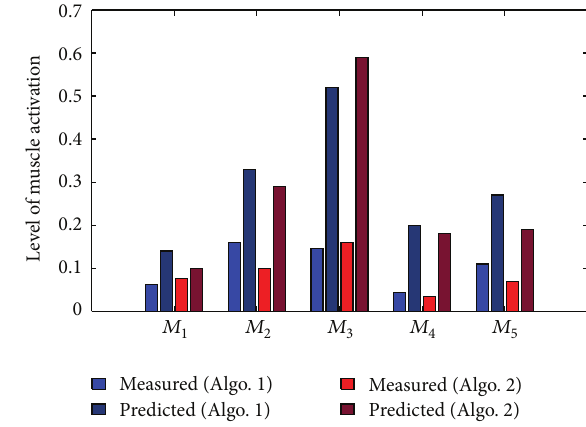
Figure 14: Level of muscle activation (Target: 𝑀 3 ).